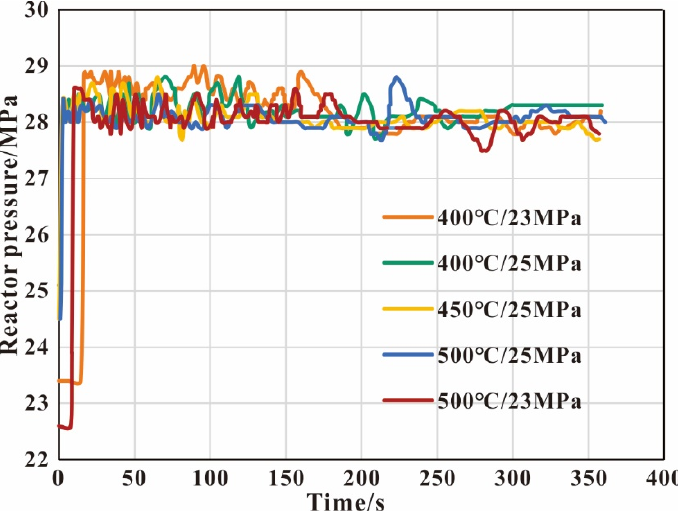
Figure 15. Changes of pressure in the reactor during the experiment of supercritical water–crude oil reaction under different initial temperature and pressure conditions. Table 7. Gas chromatographic analysis results after supercritical water–diesel reaction.